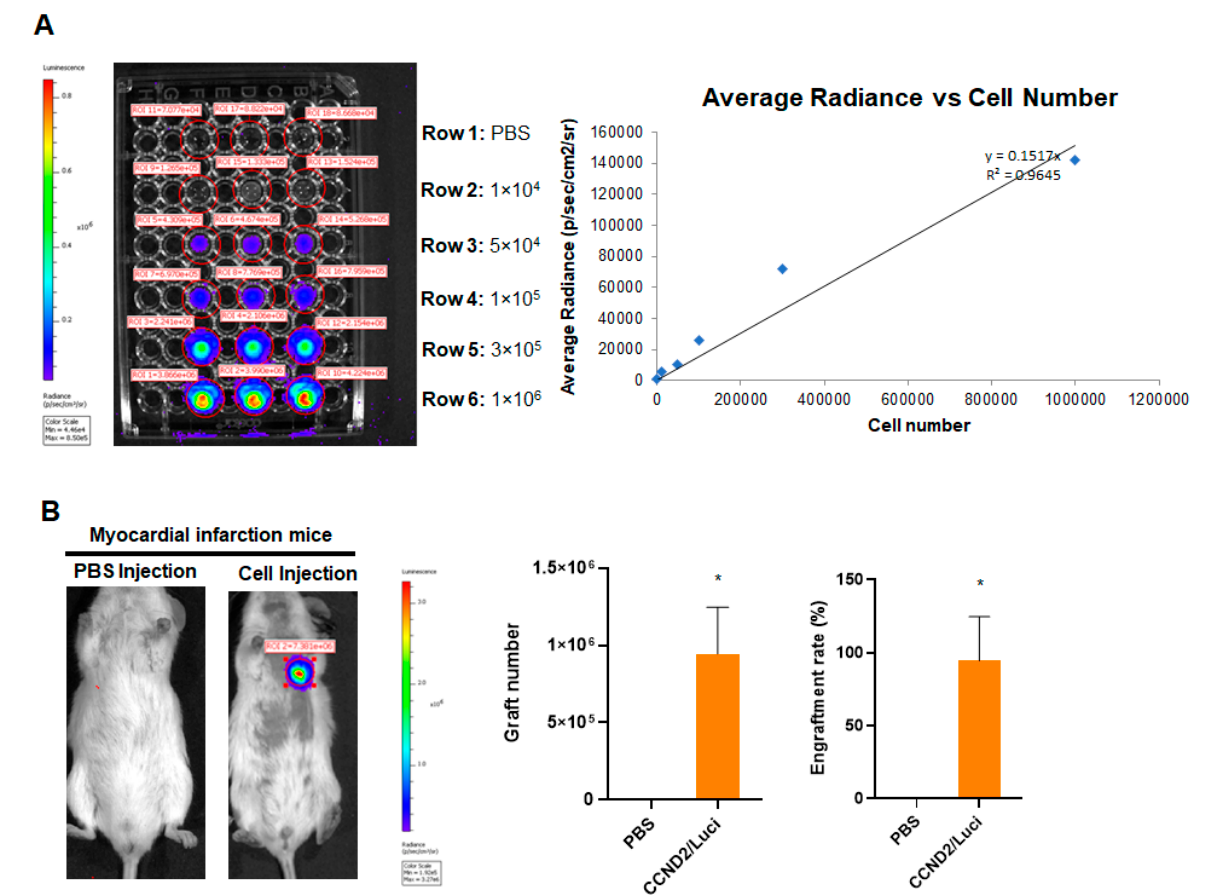
Figure 3. Quantification of graft size in animals receiving CCND2 overexpressing hiPSC-CMs. Immediately after surgically induced myocardial infarction, the mice received intramyocardial injection of 1 million hiPSC-CCND2 OE /Luci OE CMs. Control mice received intramyocardial injection of PBS after myocardial infarction induction. The transplanted cells carried a luciferase reporter plasmid and were of human origin; thus, engraftment was evaluated via bioluminescence imaging at 6 months after cell transplantation. ( A ) A standard curve was generated from bioluminescence measurements of known quantities of hiPSC-CMs. ( B ) Six months after myocardial infarction induction and treatment with intramyocardial injections of PBS (n = 6 animals) or hiPSC-CCND2 OE /Luci OE CMs (n = 10 animals), the mice were injected with luciferin, and bioluminescence images were collected 10 min later. Bioluminescence signal intensity was compared to the standard curve to determine the number of engrafted cells; then, the engraftment rate was calculated by dividing the number of engrafted cells by the total number of cells administered and expressed as a percentage. *— p < 0.05 versus PBS-receiving group by Student’s t-test.